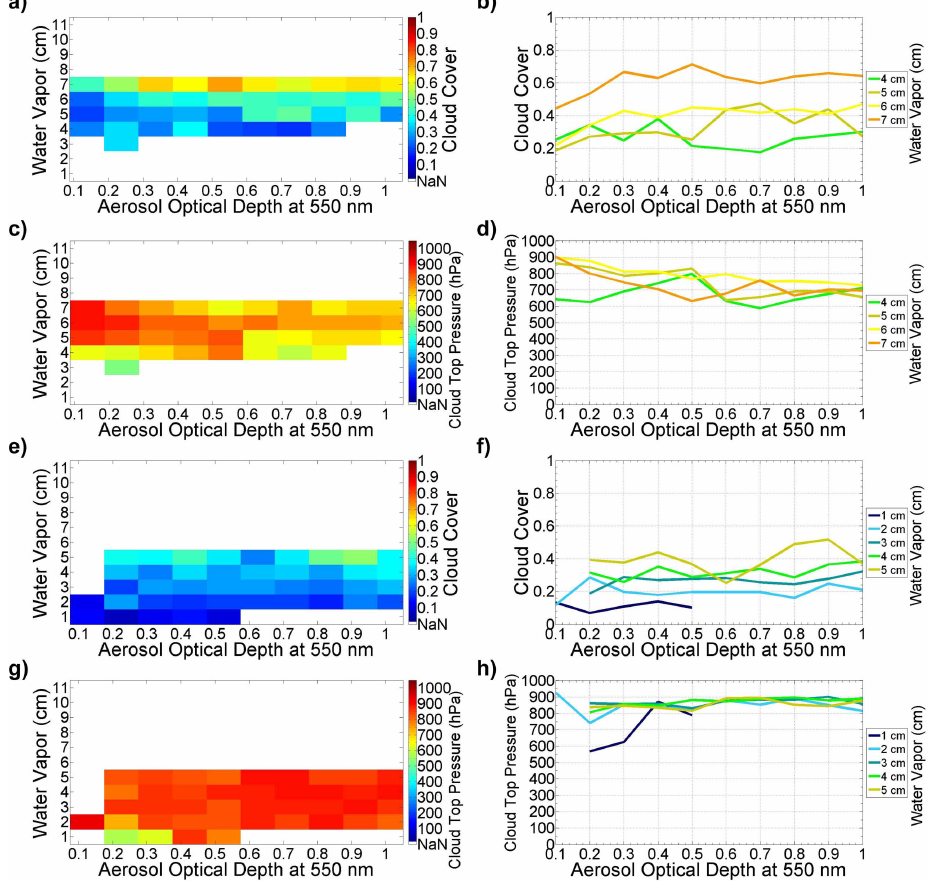
Figure 4. As in Fig. 2, but for the Pearl River Delta (PRD) urban